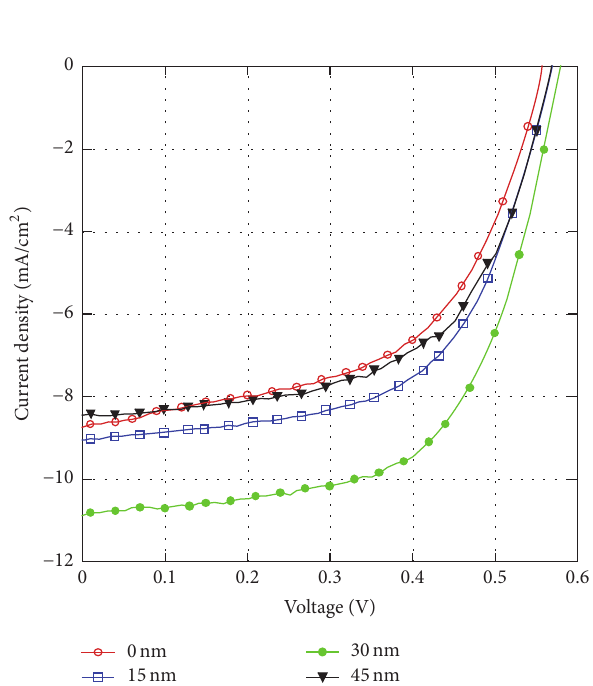
Figure 5: J-V characteristics of the devices with different ZnO thicknesses, measured under 100 mW/cm 2 illumination (AM 1.5G). The structure of the devices is ITO/PEDOT:PSS/ P3HT:PC 70 BM/ZnO/Al.